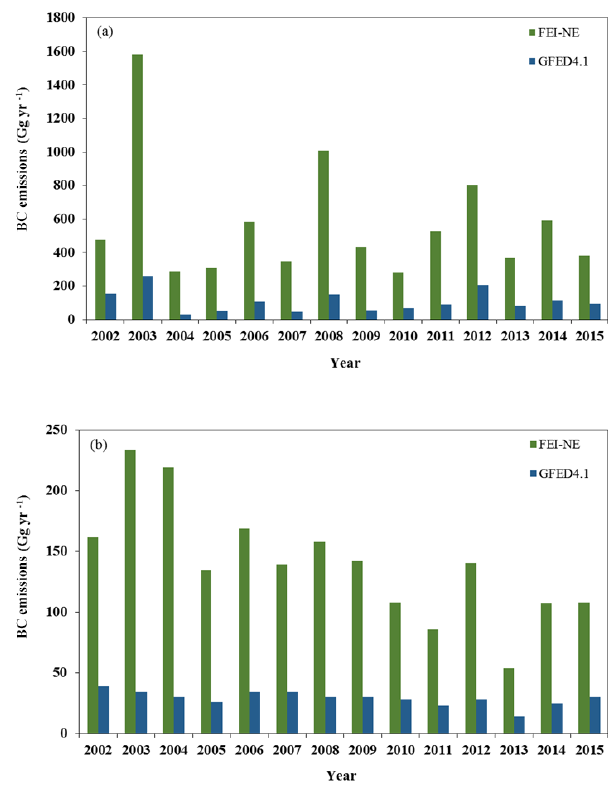
Figure 11. Comparisons of annual BC emissions in different geo- graphic regions in northern Eurasia from (a) fires in FEI-NE Russia vs. GFED4.1 BOAS, and (b) fires in FEI-NE eastern Asia, central and western Asia, and Europe vs. GFED4.1 CEAS and EURO from 2002 to